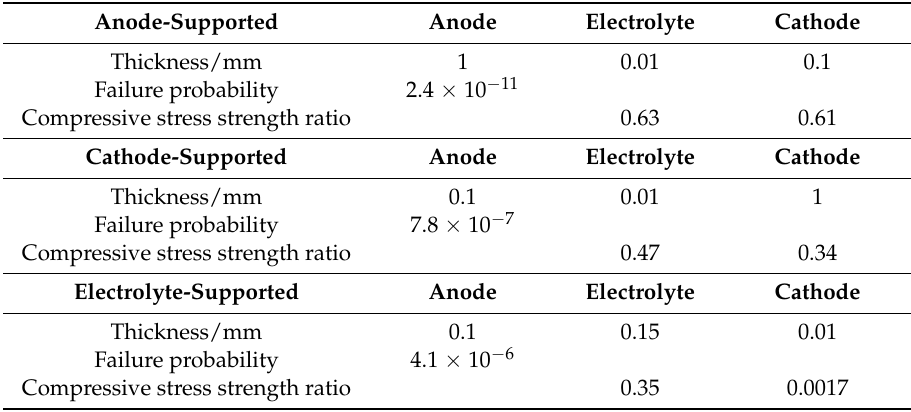
Table 4. Comparison of the anode failure probability and the compressive stress strength ratios of the electrolyte and the cathode for the anode-, cathode-, and electrolyte-supported